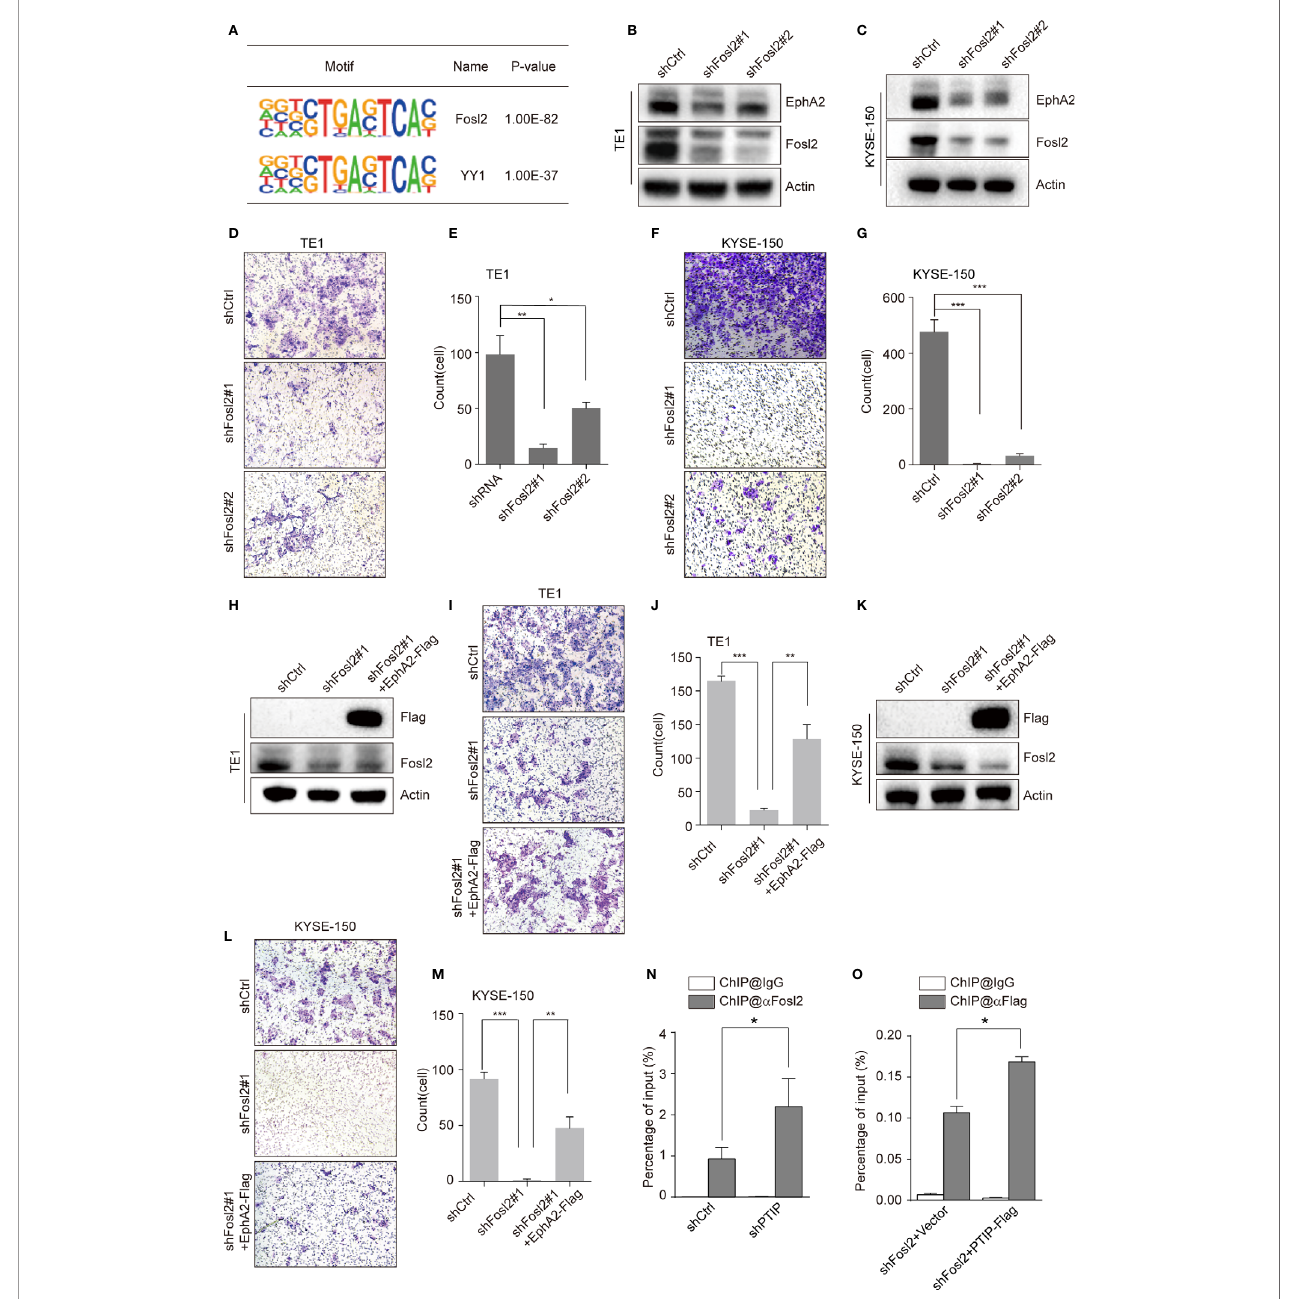
FIGURE 6 | PTIP inhibits EphA2 expression by competing with Fosl2 for binding to EphA2. (A) PTIP highly enriched binding motifs in bioPTIP ChIPseq were identi fi ed by HOMER. P -values are indicated within the boxes. (B, C) Western blot analysis of Fosl2 and EphA2 expression in Fosl2 knockdown (shFosl2#1, shFosl2#2) and control (shCtrl) TE1 (B) and KYSE-150 (C) cells. (D – G) The effect of Fosl2 knockdown on the invasiveness of TE1 (D, E) and KYSE-150 (F, G) cells. For invasion assay, six different microscopic fi elds (magni fi cation, ×10) from at least three independent experiments were examined; Relative intensities of the fi elds were measured (n ≥ 3). Representative images and statistical plots are shown; Mean ± s.d. are given for three independent experiments. One-way ANOVA; * P < 0.05; * P < 0.01; *** P < 0.001. (H – M) Western blot showing stable expression of Flag-EphA2 in shFosl2#1 TE1 cells (H) and KYSE-150 cells (K) . Overexpression EphA2 partially restored TE1 cells (I, J) and KYSE-150 cells (L, M) invasive ability, which attenuated by depletion of Fosl2. For invasion assay, six different microscopic fi elds (magni fi cation, ×10) from at least three independent experiments were examined; Relative intensities of the fi elds were measured (n ≥ 3). Representative images and statistical plots are shown; Mean ± s.d. are given for three independent experiments. One-way ANOVA; * P < 0.05; *** P < 0.001. (N, O) ChIP-qPCR analyses of the relationship between Fosl2 and PTIP in transcriptional regulation for EphA2. Mean ± s.d. are given for three independent experiments. Unpaired, two-tailed Student ’ s t-test; * P <